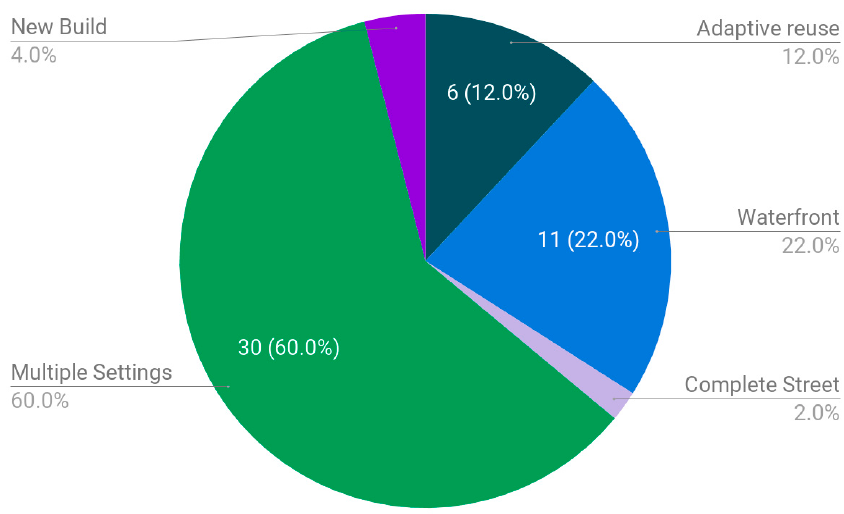
Figure 4. Distribution of urban greenway studies by landscape setting.